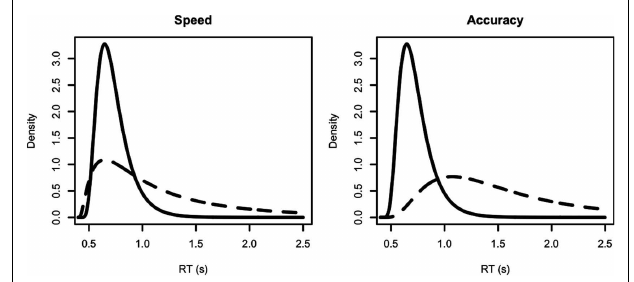
FIGURE 2 | Examples of independent Lognormal distributions, all with shift θ = 0.4s. Solid lines represent the true (correct response) accumulator distribution, dashed lines the false (error response) accumulator distribution.The left panel represents a speed-emphasis condition, the right panel an accuracy emphasis condition. For the speed condition the ( µ , σ 2 ) parameters for each density are: solid line ( − 1.2, 0.2), dashed line ( − 0.5, 0.9).The corresponding mean RTs for correct and error responses are 0.7 and 0.64s (fast errors) with 75% accuracy. For the accuracy condition the ( µ , σ 2 ) parameters for each density are: solid line ( − 1, 0.2), dashed line (0, 0.4).The corresponding mean RTs for correct and error responses are 0.78 and 0.84s (slow errors) with 90%